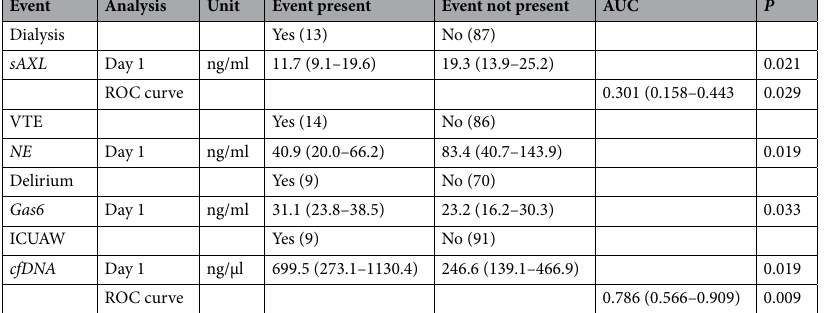
Table 3. Association between events during stay at the ICU and markers measured in COVID-19 patients. Indicated is the event and significant altered plasma markers. The difference at day 1 or the delta is calculated with Mann–Whitney U and the predictive power of an event by a marker is calculated by the AUC of the ROC curve. Values are considered significant if p < 0.05. VTE various thromboembolic events, ICUAW Intensive Care Unit Acquired Weakness, ROC receiver operating characteristic, AUC area under the